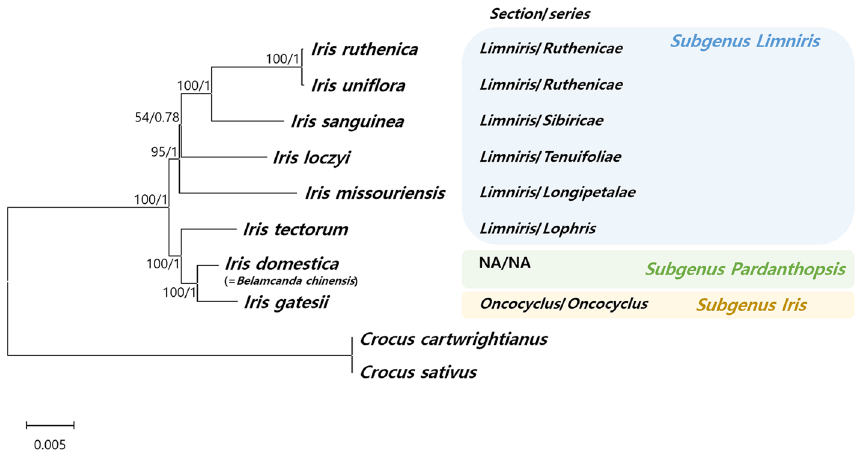
Figure 7. Phylogenetic tree of Iris species constructed using maximum likelihood bootstrap analysis and Bayesian posterior probability. Maximum likelihood topology is shown with bootstrap support values and Bayesian posterior probabilities given at each